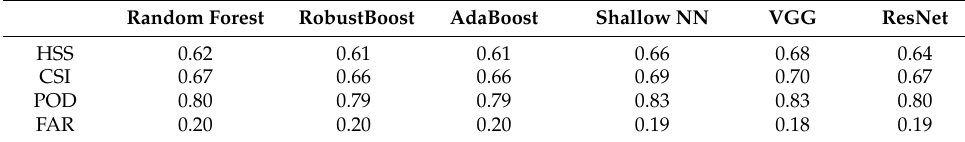
Table 5. Snowfall detection statistics.